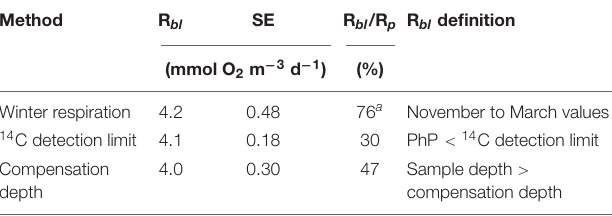
TABLE 2 | The rate of baseline respiration using different approaches for its